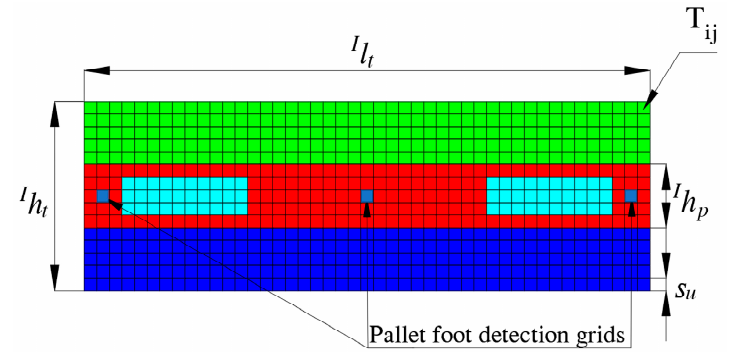
Figure 5. Labeled template example. Element labels are represented with different colors. Green represents goods. Red represents pallets. Blue represents ground. Light blue represents pallet holes. The grids are compression units of label templet. s u and T ij represent the grid compressing unit size and the grid unit vector of Labeled templet, respectively (explained in Section 2.5 below). The pallet foot detection grids are explained in Section 2.7 below.